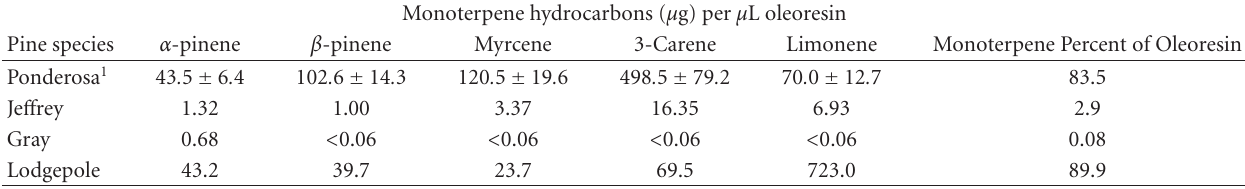
Table 3: Amounts of monoterpene hydrocarbons in oleoresin samples from four species of pine (near Bass Lake, California, USA, 17 October